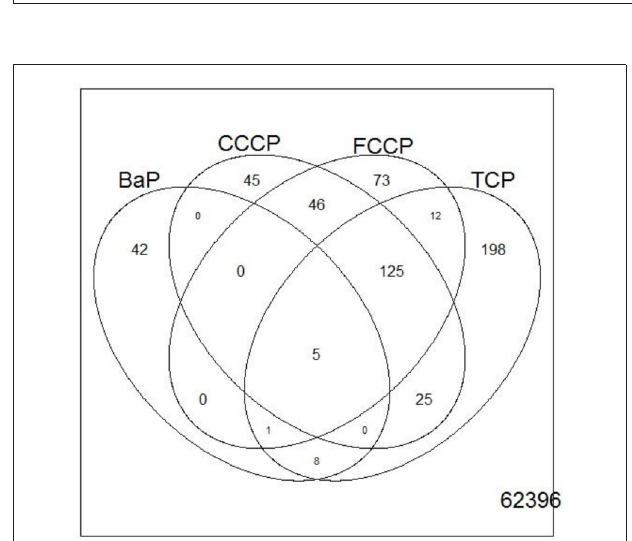
FIGURE 6 | Venn diagram showing the overlap of genes that were regulated with a fold change of > 2 or < 0.5 (|M| > 1) between treatments of microarray experiment 1. Only five genes overlap between all